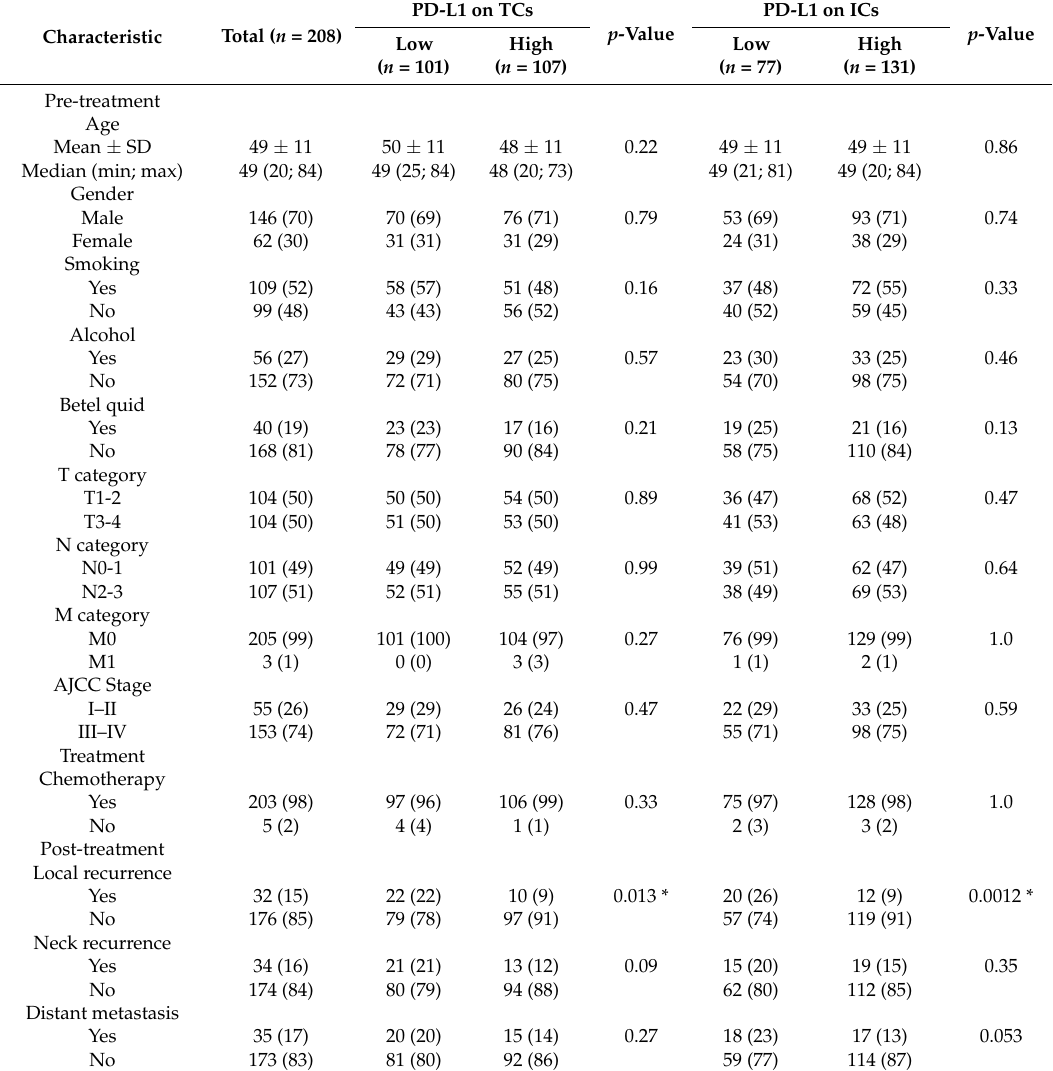
Table 1. Clinical characteristics grouped by programmed death-ligand 1 (PD-L1) expression on tumor cells (TCs) or immune cells (ICs).